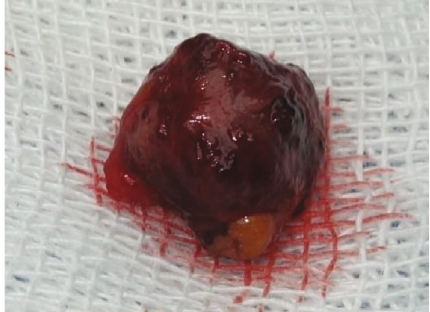
Figure 4: Intraoral incision on the buccal mucosa revealed a spherical lesion just underneath the buccinator muscle.